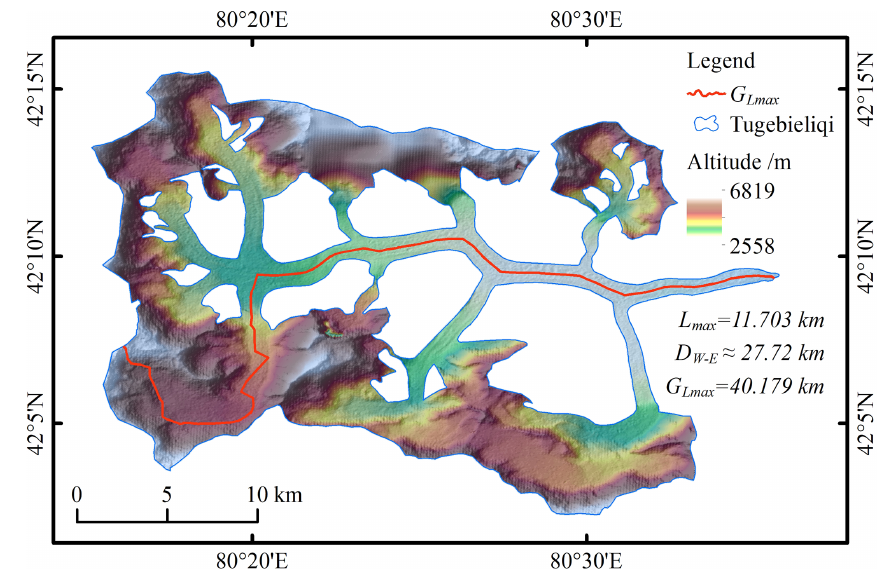
Figure 14. The schematic of the longest centerline of Tugebieliqi Glacier ( L max : the corresponding length of this glacier in the RGI v6.0; D W–E : the distance from west to east of this glacier; G Lmax : the length calculated by our method). Table 4. The statistics of assigning tasks and results of execution in tests. Task ID Assigned amount Completed